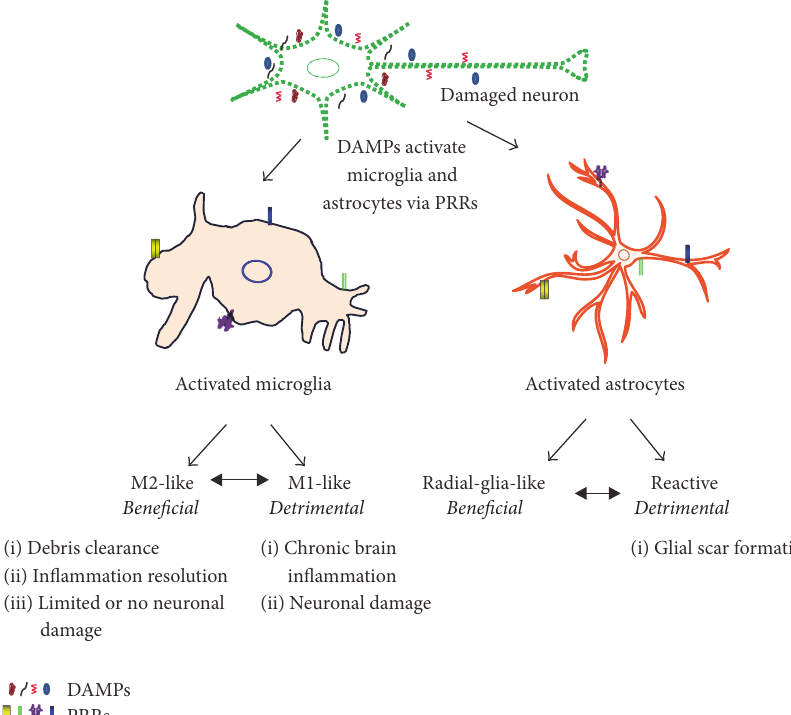
Figure 2: Response of microglia and astrocytes to the brain injury. DAMPs can signal PRRs expressed in astrocytes and microglia, promoting their activation. Depending on the injury site, severity of brain injury, surrounding environment, and signaling strength, astrocytes and microglia may respond to remove stimulants or to secrete inflammatory mediators. Typically, beneficial activation (M2-like microglia and radial-glia-like astrocytes) is associated with the elevated release of neurotrophic factors, anti-inflammatory cytokines (e.g., IL-4 and IL- 10), and enzymes (e.g., arginase 1 and insulin-degrading enzymes) that enhance phagocytic activity. Conversely, detrimental activation of astrocytes and microglia is associated with the elevated and sustained expression of inducible nitric oxide synthase, reactive oxygen species, proinflammatory mediators (e.g., IL-1 𝛼 / 𝛽 , IL-6, and TNF), and decreased secretion of neurotrophic factors. These divergent responses may determine whether microglia and astrocytes lead to clear tissue debris or promote chronic